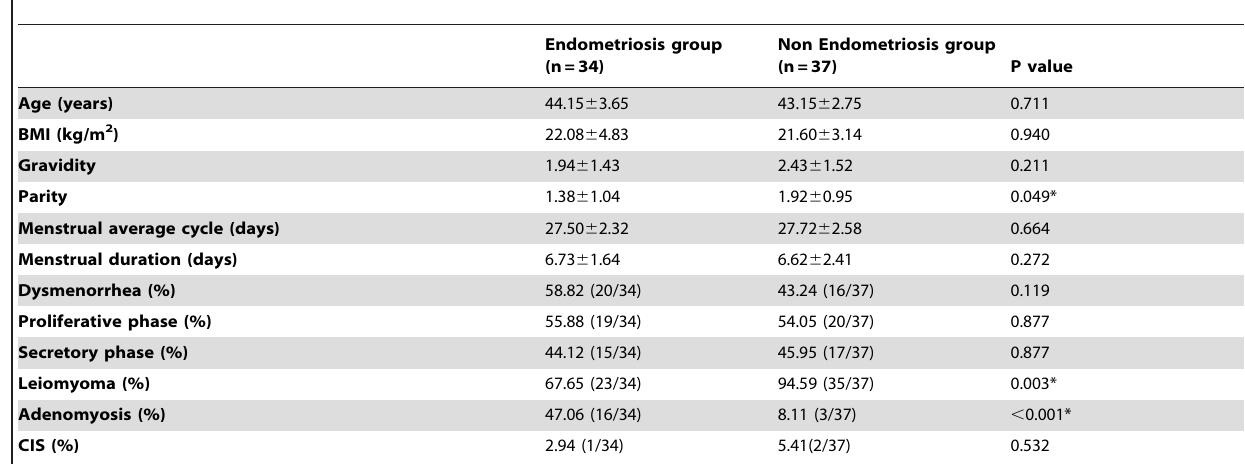
Table 1. Clinical characteristics and pathological diagnoses of uterus (endometriosis and non-endometriosis groups).